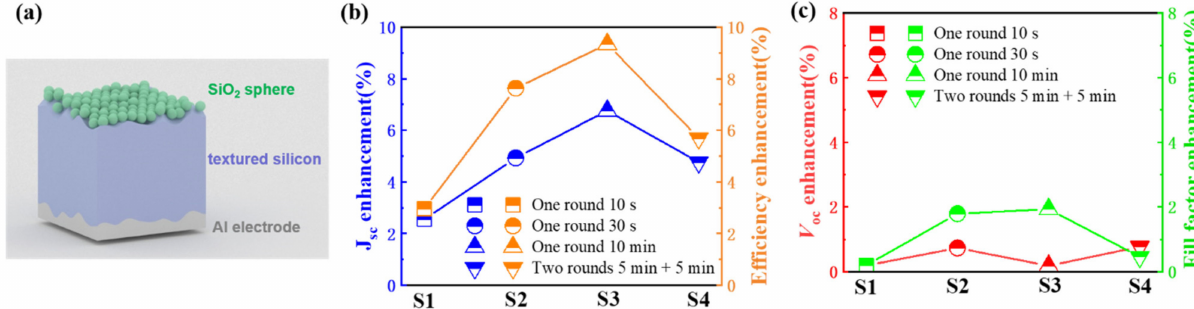
Figure 5. Comparison of electrical parameters enhancement with different SiO 2 nanocoatings. ( a ) Schematic illustration of the textured Si solar cell with SiO 2 nanosphere coating; ( b ) Relative enhancement of J sc and power conversion efficiency of the textured Si solar cells; ( c ) Relative enhancement of V oc and fill factor of the textured Si solar